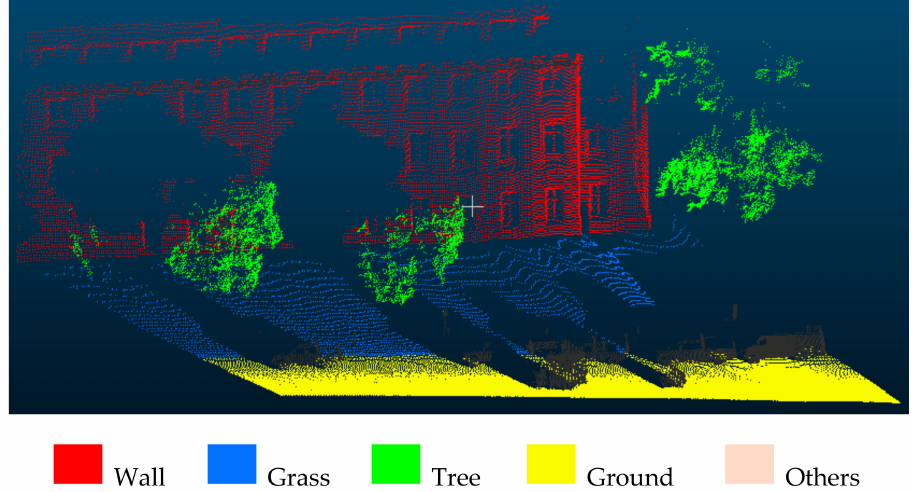
Figure 5. Dataset3, the training set of the Oakland dataset. Points were filtered and remapped to four primary classes (wall, grass, tree, and ground).